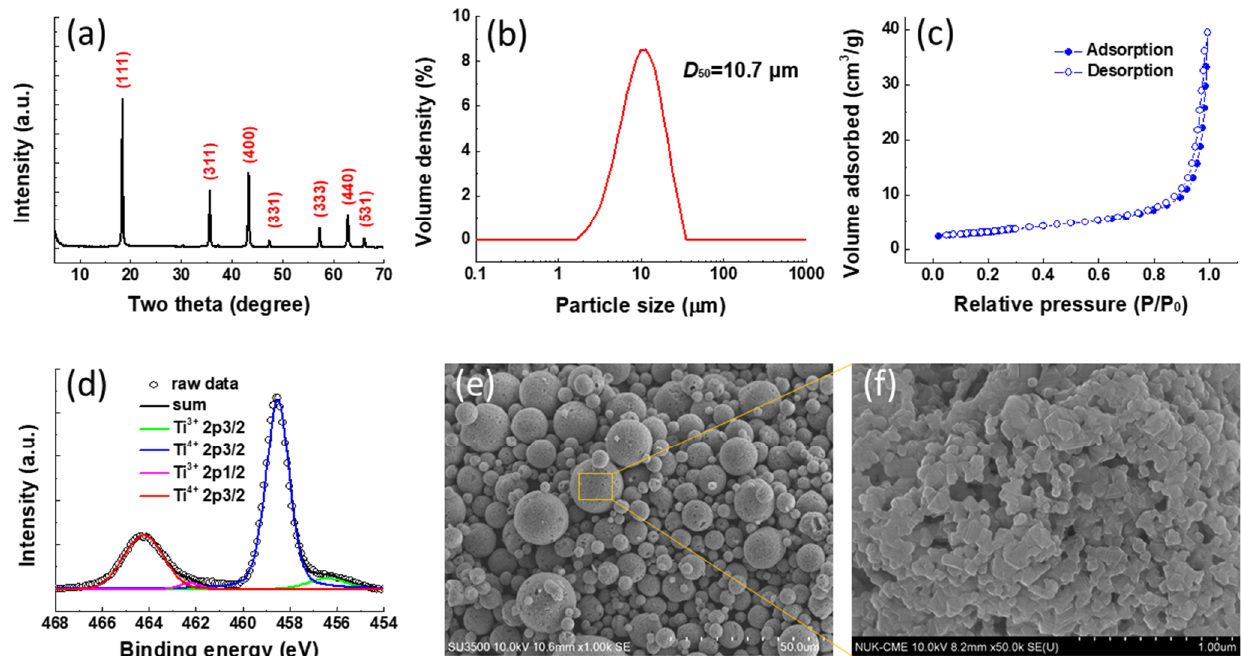
Figure 5. ( a ) The XRD pattern of the spray-dried Li 4 Ti 5 O 12 (LTO) powder; ( b ) the particle size distribution of the LTO; ( c ) the nitrogen adsorption/desorption isotherms of the LTO; ( d ) peak deconvolution of the Ti 2p XPS spectrum of LTO powder; ( e , f ) scanning electron microscopy (SEM) images of the LTO with different magnifications.